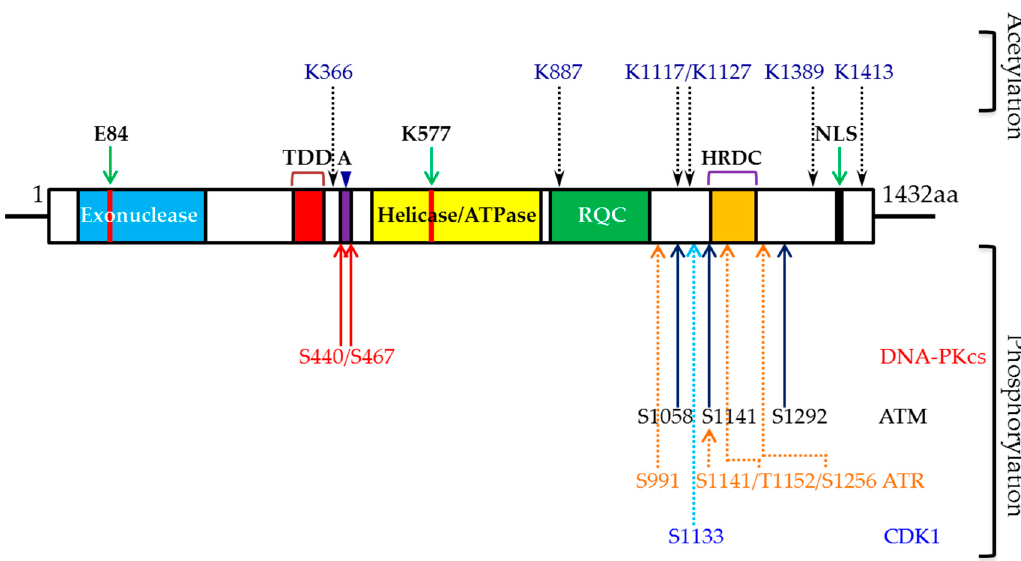
Figure 1. Schematic showing different functional domains, exonuclease (E84), helicase (K577) active sites, and DNA-PKcs (S440 and S467), ATM (S1058, S1141 and S1292), ATR (S991, S1411, T1152 and S1256) and CDK1 (S1133) phosphorylation, and acetylation (K366, K887, K1117, K1127, K1389 and K1413) sites in WRN. TDD-Trimerization (oligomerization/multimerization) domain (250–333aa); A-acidic repeats (2X27; 424–477 aa); RQC-RecQ C-terminal (749–899 aa); NLS-nuclear localization signal; aa-amino acid; black dotted lines denote acetylation events; solid red arrows indicate DNA-PKcs-mediated phosphorylation sites; solid dark blue lines represent ATM-mediated phosphorylation events; dotted orange arrows represent ATR-dependent phosphorylation sites; light blue dotted line represents CDK1-dependent phosphorylation site.